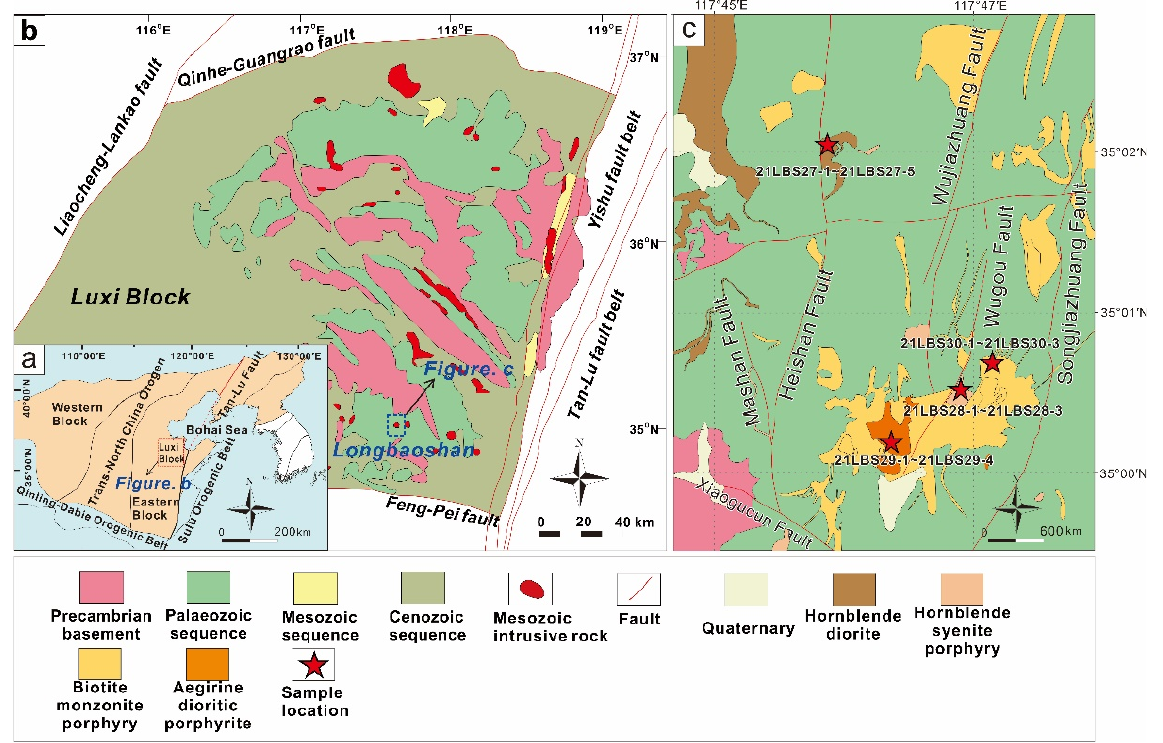
Figure 1. ( a ) Simplified geological map of eastern China and the location of Luxi Terrane, modified after [19]. ( b ) Sketch geological map of the eastern Luxi Terrane, modified after [50,51]. ( c ) Geological sketch of the Longbaoshan alkaline complex.